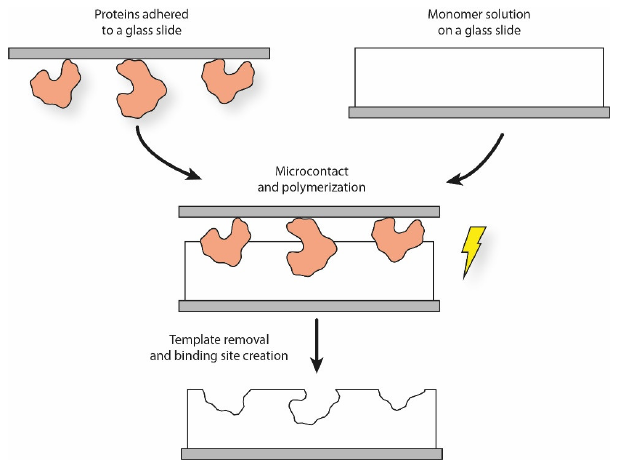
Figure 2. Simplified schematics of the micro-contact printing procedure for proteins.